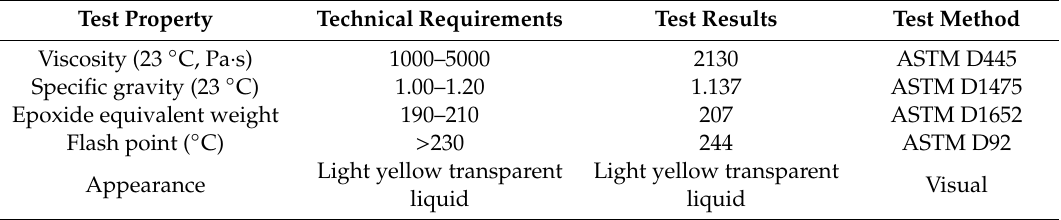
Table 2. Performance and technical requirements of the main agent for epoxy resin.